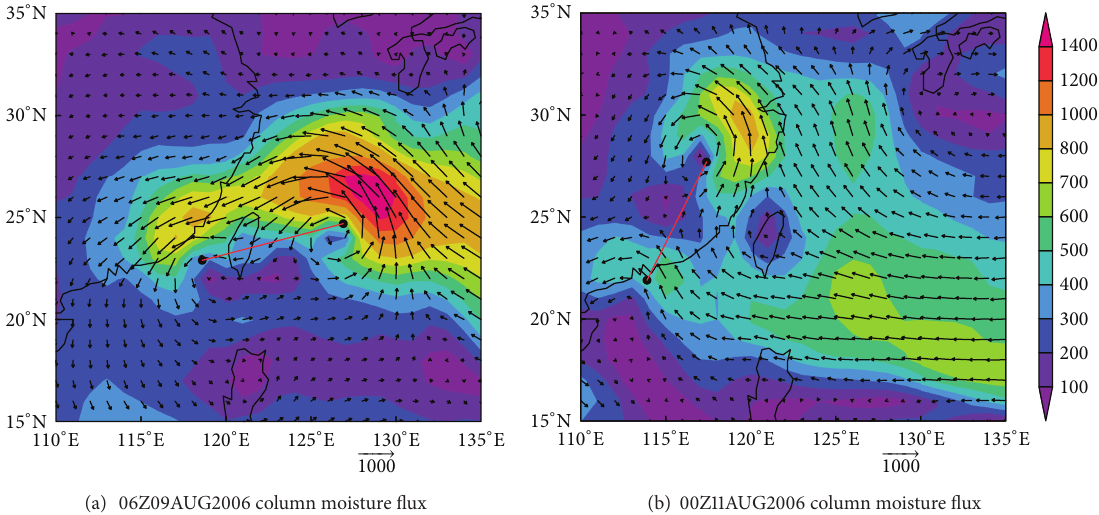
Figure 8: Volume moisture fluxes (vectors) with their magnitude (shaded, kg m −1 s −1 ) at (a) 0600 UTC 09 August, 2006, and (b) 0000 UTC 11 August, 2006, computed from the 1 ∘ × 1 ∘ NCEP FNL operational global analysis. The red lines connect two centers of Saomai and Bopha.